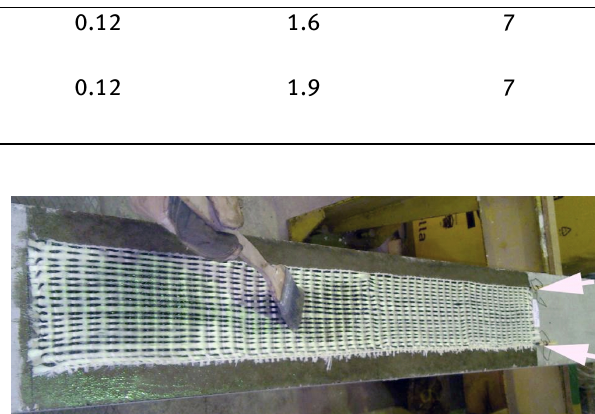
Figure 5: Application of textile sensor on the surface of reinforced concrete